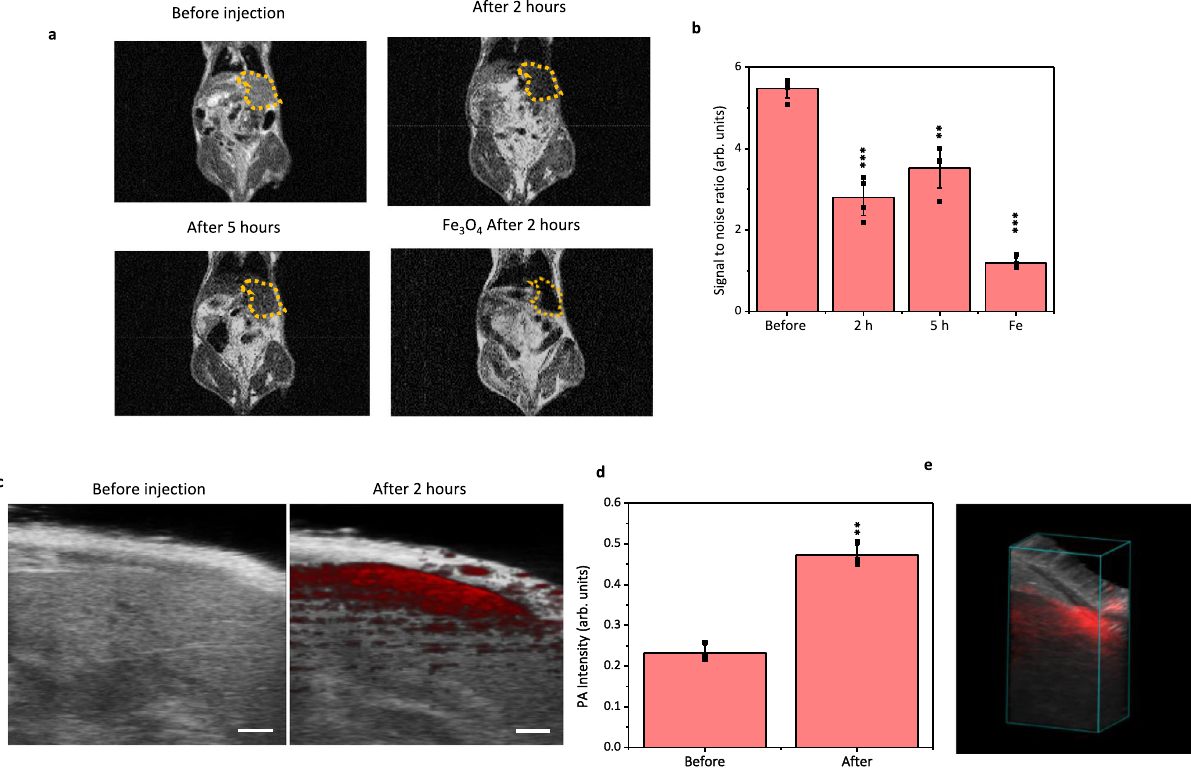
Fig. 4 Feasibility of DHBA – PPy@DSPE – PEG nanoparticles for in vivo imaging. a T 2 -weighed MRI images of BALB/c nude mice before, after 2 h, after 5 h of injection of DHBA – PPy@DSPE – PEG nanoparticles, and after 2 h of injection of Fe 3 O 4 nanoparticles. b The variation of signal/noise ratio of the dotted circled region in the liver. Error bars in b represent mean ± s.d., with n = 4 independent experiments. Statistical signi fi cance for comparison of before injection, after 2 h, after 5 h, and Fe 3 O 4 groups was determined by two-tailed Student ’ s t -test (* p < 0.05, ** p < 0.01, and *** p < 0.001). p 2h = 4.05E - 05, p = 3.57E-04, p = 6.37E-08. c Photoacoustic imaging acquired at 1280 nm of the liver region before and after injection of DHBA – PPy@DSPE – PEG 5h Fe nanoparticles. The scale bar is 1 mm. Experiments were performed three times with similar results. d The variation of photoacoustic intensity in the liver. Error bars in b represent mean±s.d., with n = 3 independent experiments. Statistical signi fi cance for comparison of before injection and after 2 h was determined by two-tailed Student ’ s t -test (** p = 1.46E-04< 0.01). e 3D reconstruction (with 1mm step) of photoacoustic images acquired at 1280nm of the liver region after injection of DHBA – PPy@DSPE – PEG